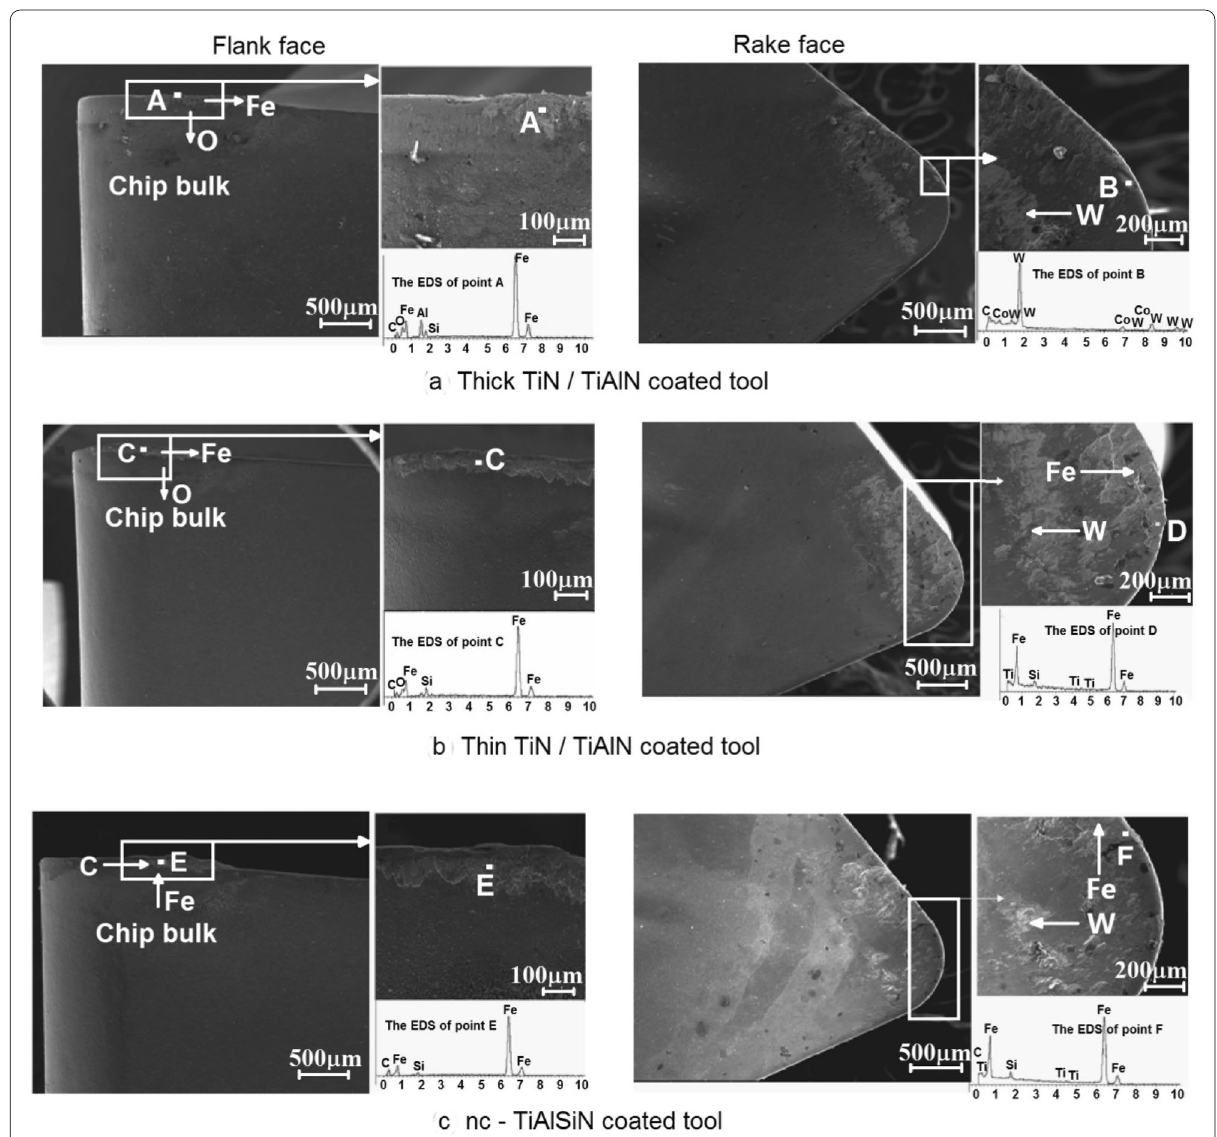
Figure 8 Tool wear morphologies of the three coated tools in dry turning of MCI ( v